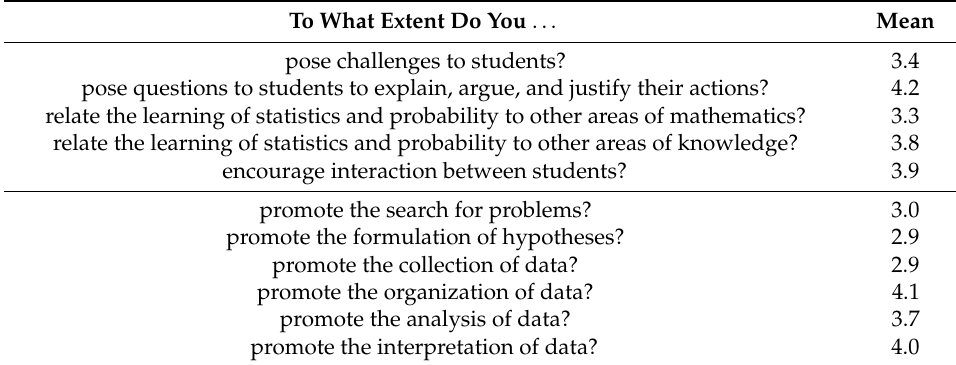
Table 2. Mean values of the participating teachers’ actions. To What Extent Do You